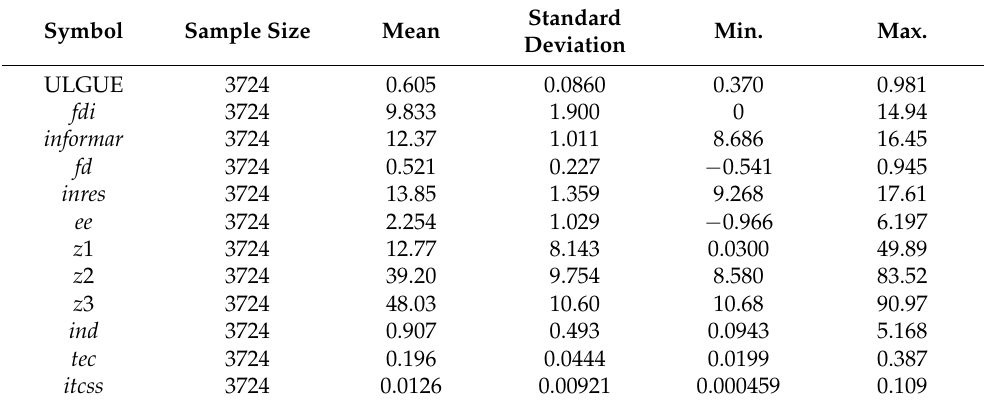
Table 2. Descriptive Statistics.